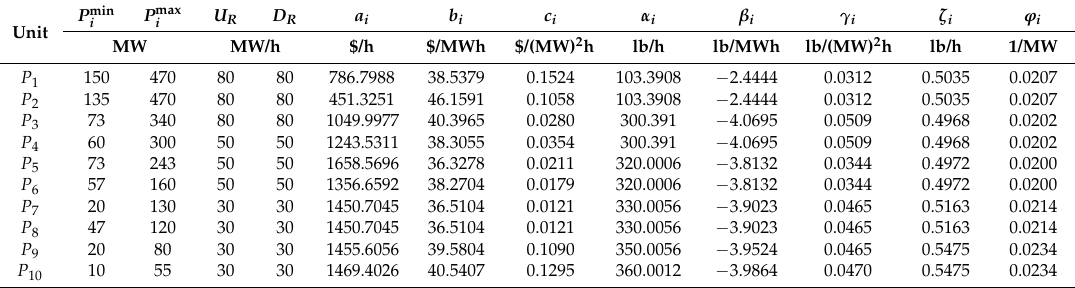
Table 2. Generator characteristics.